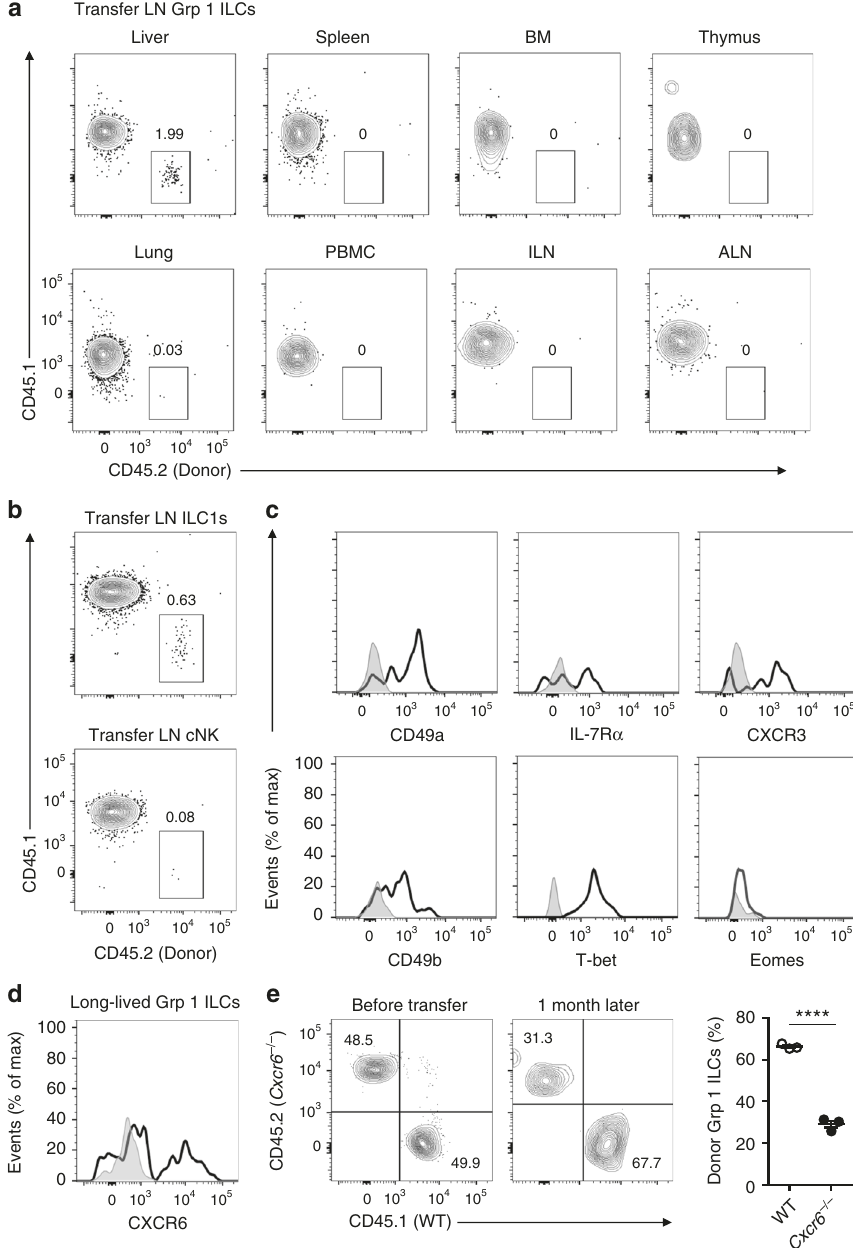
Fig. 5 LN memory IL-7R α + ILC1s selectively reside in the liver. a LN group 1 ILCs from OXA-sensitized (72 h) Rag1 − / − mice (CD45.2 + ) (2 × 10 5 cells) were adoptively transferred into CD45.1 mice. Donor cells were analyzed 2 months later. Representative density plots are of cells gated on CD3 − NK1.1 + . Data are representative of two independent experiments ( n = 2 in each experiment). b LN IL-7R α − cNK cells or IL-7R α + ILC1s from OXA-sensitized (72 h) Rag1 − / − mice (CD45.2 + ) (1 × 10 5 cells) were adoptively transferred into CD45.1 mice. One month later, donor cells were analyzed in recipient livers. Representative density plots are of cells gated on CD3 − NK1.1 + . Data are representative of two independent experiments ( n = 2 in each experiment). c Expression of CD127, CD49a, CXCR3, CD49b, T-bet, and Eomes by donor-derived ILC1s in recipient livers of b . Histograms are of cells gated on CD3 − NK1.1 + CD45.2 + CD45.1 − . Data are representative of two independent experiments ( n = 2 in each experiment). d Expression of CXCR6 on donor- derived cells in recipient livers of a . Data are representative of two independent experiments ( n = 2 in each experiment). e OXA-sensitized WT (CD45.1 + ) and Cxcr6 − / − (CD45.2 + ) LN group1 ILCs (2 × 10 5 cells) were adoptively transferred into sub-lethally irradiated CD45.1 + CD45.2 + mice; recipient mice were analyzed 1 month later. Representative density plots (left panels) are of liver group 1 ILCs (CD3 − NK1.1 + ), with host cells (CD45.1 + CD45.2 + ) excluded. Statistical analysis of results (right panel) showing the percentages of CD45.1 + (WT) and CD45.2 + ( Cxcr6 − / − ) cells among total donor-derived group 1 ILCs ( n = 3 in each group). Means ± SEM are shown. **** P < 0.0001, two-tailed unpaired Student ’ s t